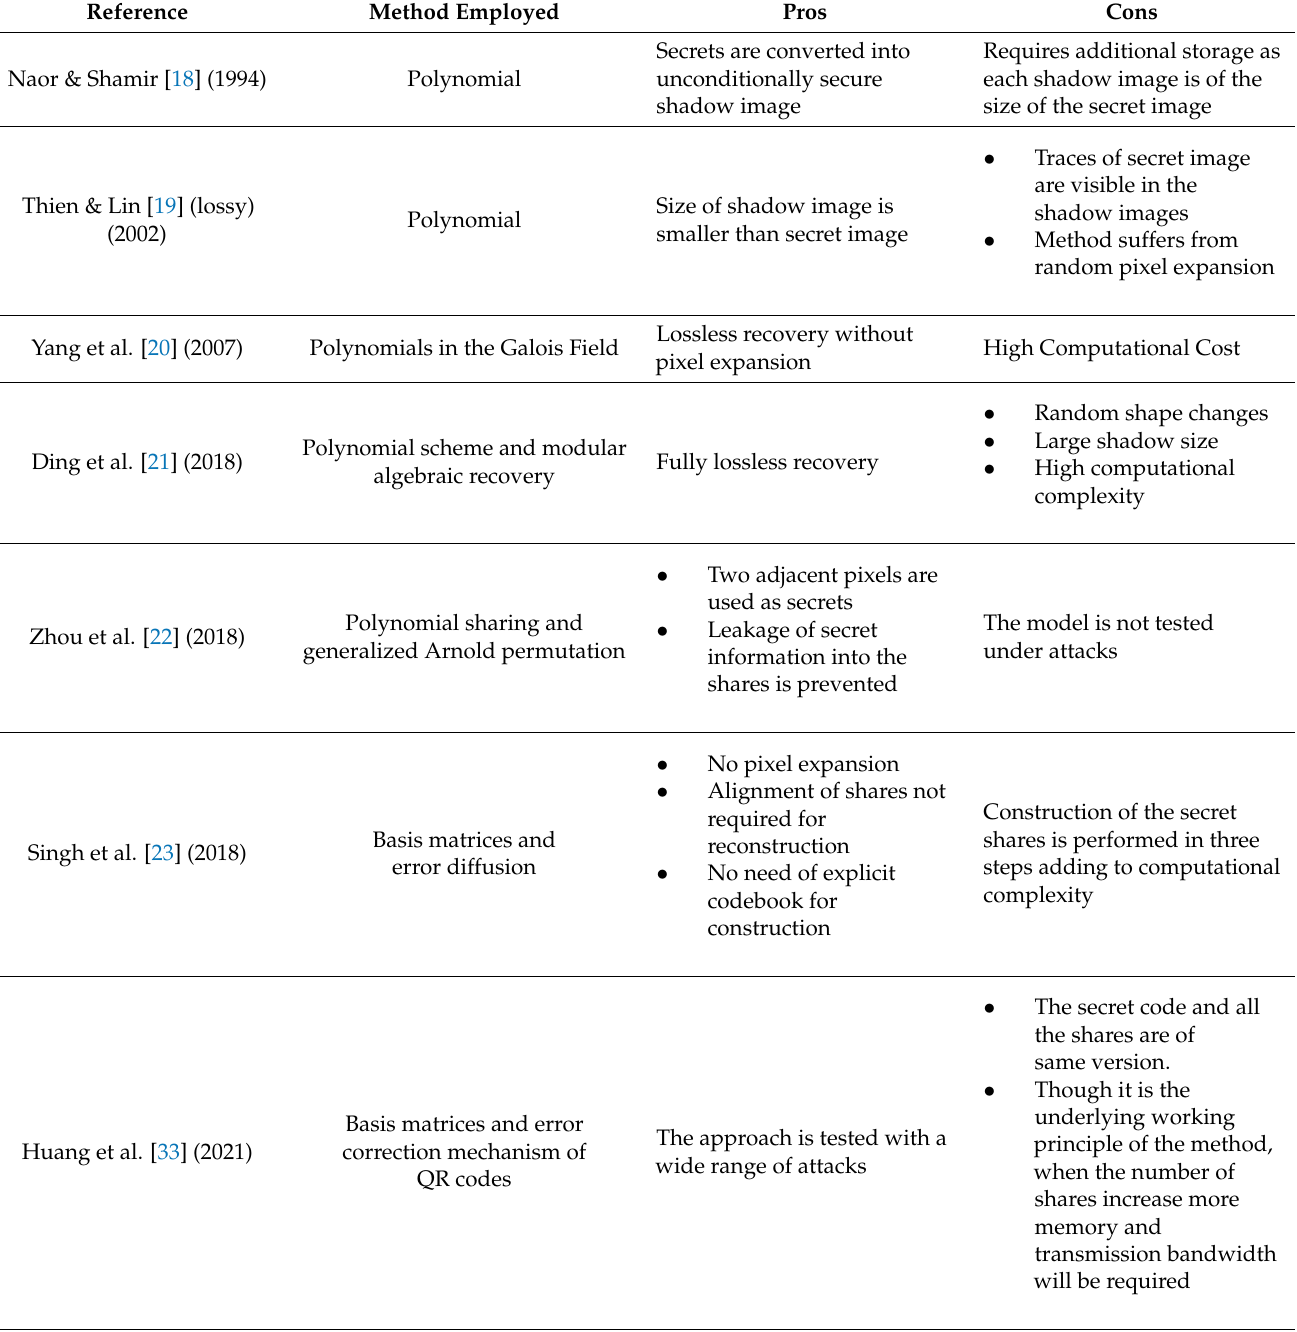
Table 1. Comparative analysis of visual secret-sharing